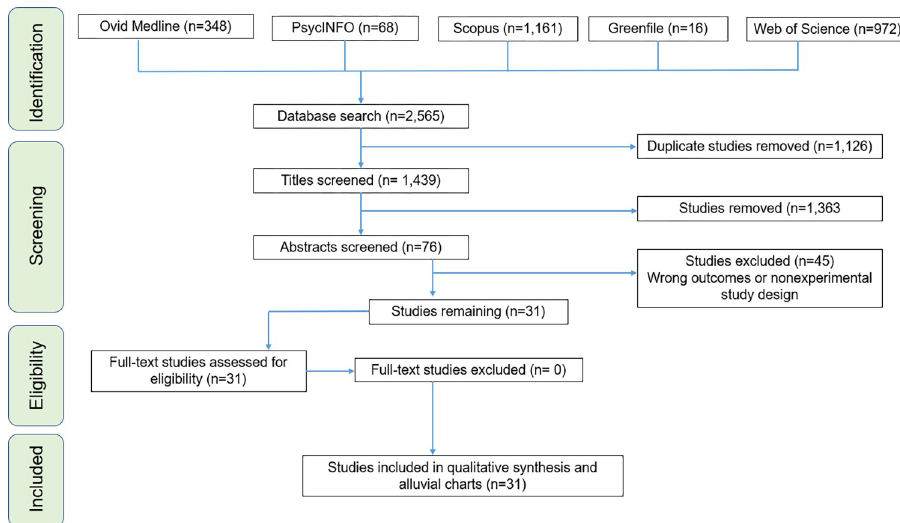
Fig 1. Graphical illustration of PRISMA 2020 guidelines in articles’ selection